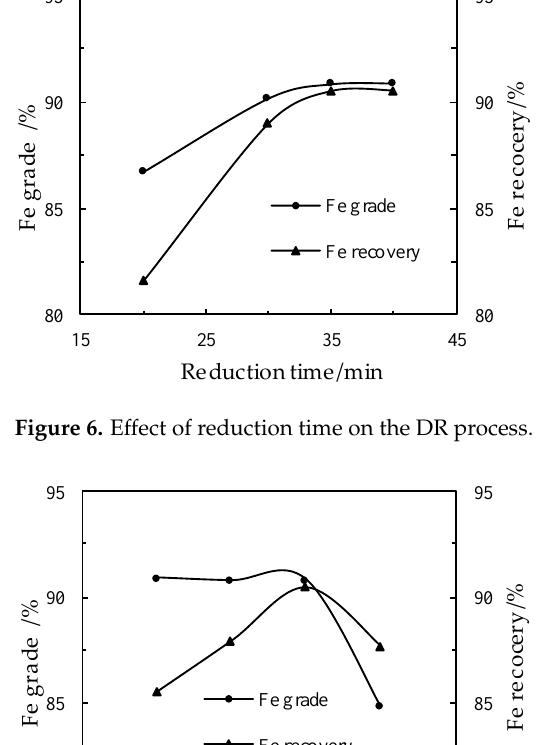
Figure 6. Effect of reduction time on the DR process.